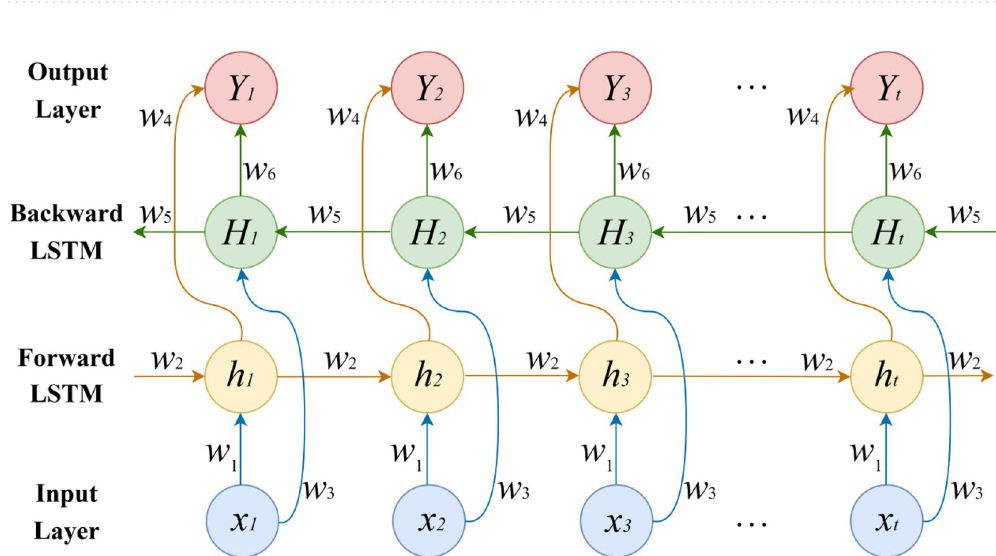
Figure 2. BiLSTM model